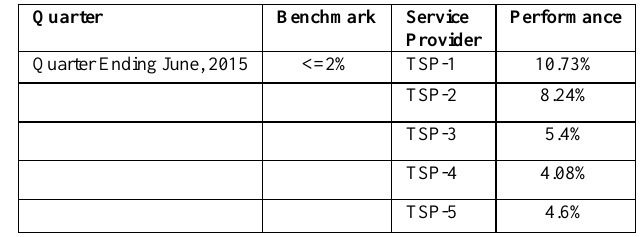
Table 1. Average performance of telecom service providers on call drop rate in quarter ending June,